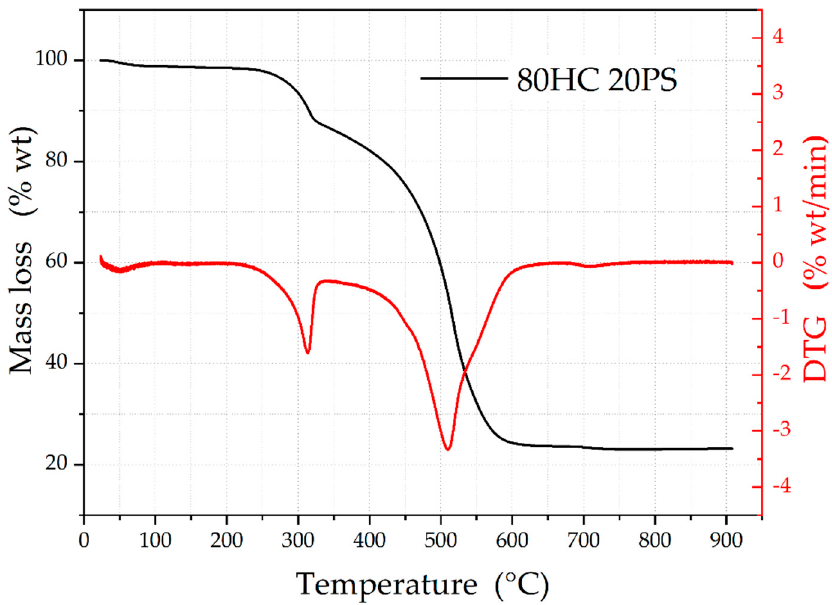
Figure 2. TG and DTG curves for 80HC 20PS at 5 ◦ C/min heating rate under an air atmosphere. Where T init denotes the temperature at the beginning of the experiment. This corre- sponds to the starting of the first stage which corresponds to initial mass loss due through moisture loss. T 1 then represents the temperature at the end of stage 1 and beginning of the stage 2, which is around 115 ◦ C for most experiments (saturation temperature of H 2 O at 1 atm is 100 ◦ C). Stage 2 marks the beginning of physical and chemical oxygen adsorption, which results in a slight increase of sample mass. During chemical adsorption, oxygen containing complexes are formed on the surface. This phenomenon is generally more pronounced for coal rather than biomass [44]. T ig represents the temperature at the ignition point which then corresponds to the beginning of stage 3. Using the DTG curve, the ignition point is marked when the mass loss rate first becomes equivalent to 1% wt./min [17,39]. After the fuel ignites, another point of interest to researchers that is made apparent by superimposing the DTG curve is the point which corresponds to maximum mass loss rate or the point with the highest gradient on the TG curve. The point is derived from the minimum inflection point on the DTG curve (DTG max ) which then corresponds to a temperature T max . DTG max is represented by Equation (3).